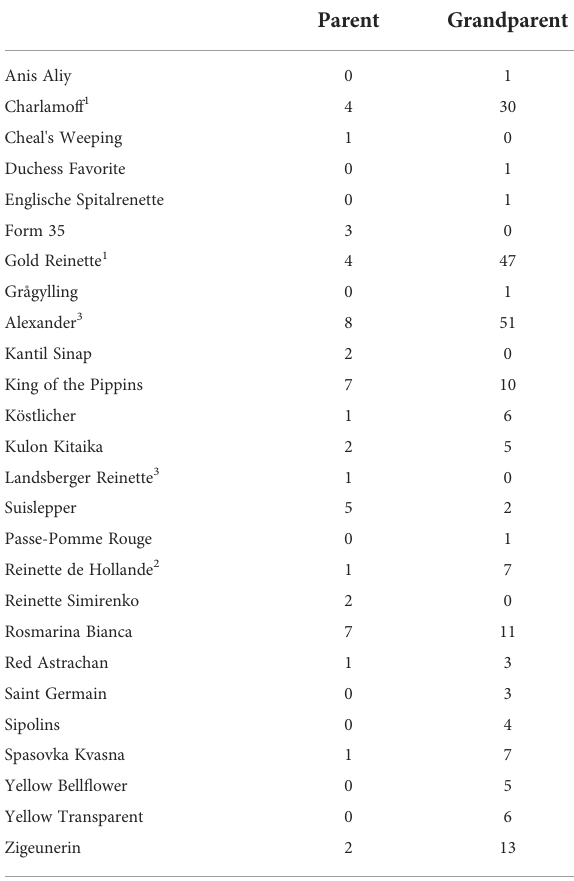
TABLE 2 Named cultivar ancestors of NPGS apple accessions labeled as Malus sieversii (excluding genotypic duplicates) identi fi ed by pedigree reconstruction using SNP array genotypic